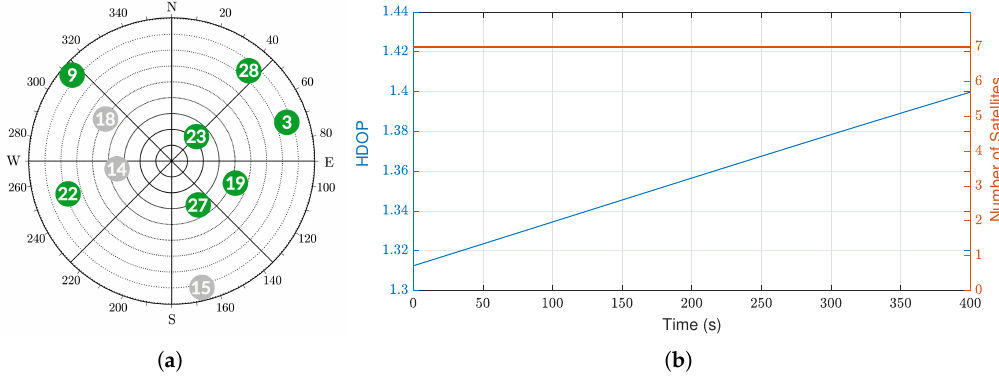
Figure 8. Simulated satellite constellations and related Horizontal Dilution Of Precision (HDOP) for record and replay experimental scenarios. ( a ) Skyplot of simulated satellites; ( b ) number of visible satellites and